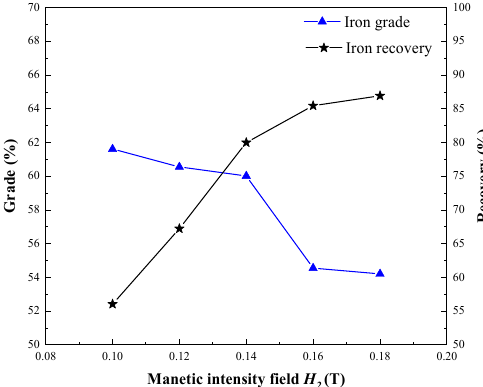
Figure 13. Effect of magnetic intensity field on iron extraction. Figure 13. E ff ect of magnetic intensity field on iron